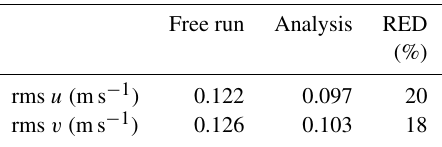
Table 5. Comparison of the meridional and zonal surface current component of free run and analysis with respect to FINO-3 ADCP measurements (ms − 1 ). The last column is the achieved reduction (RED) in